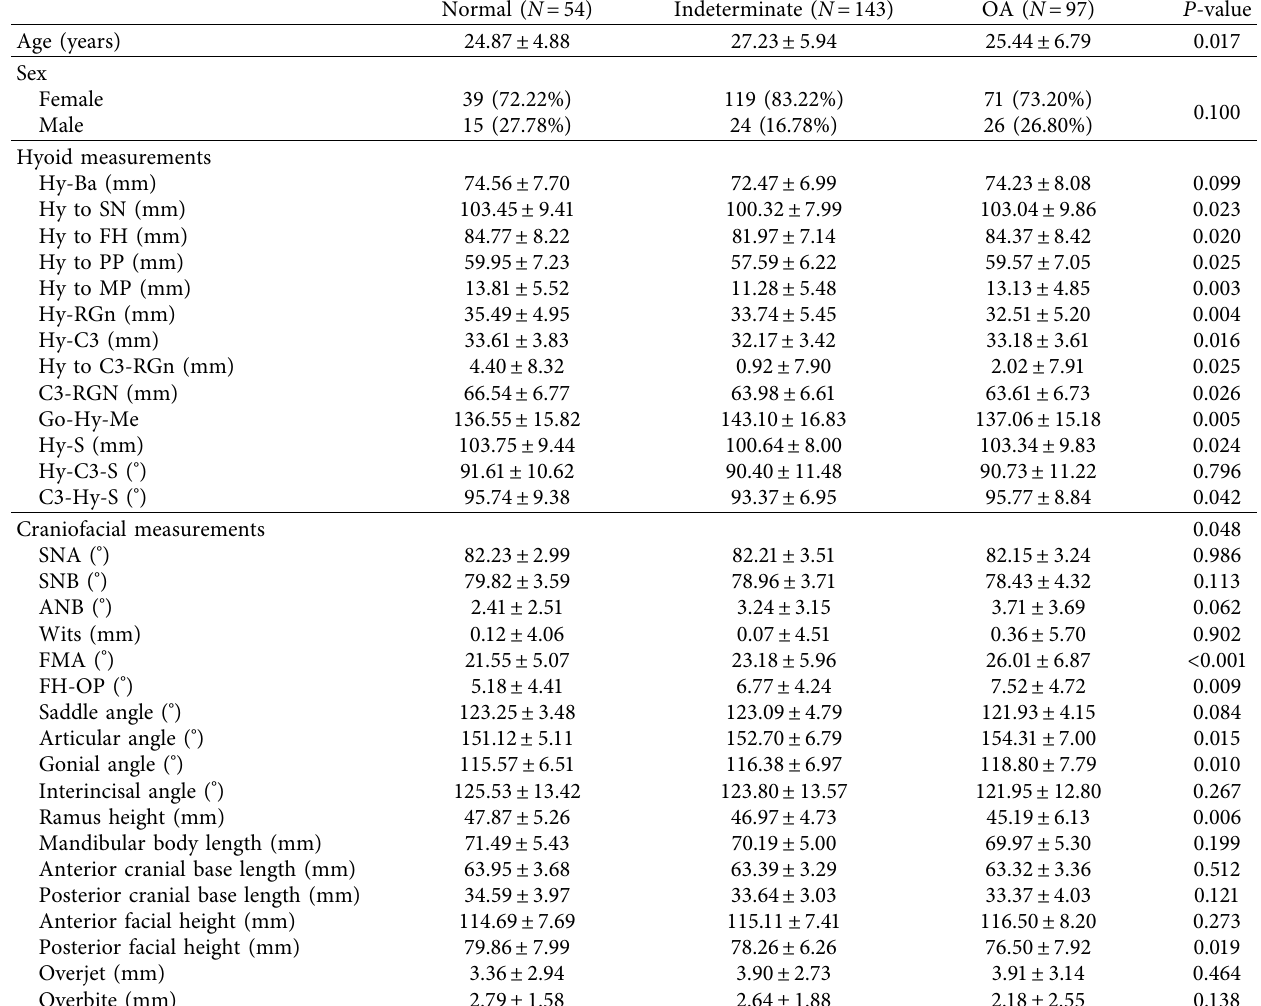
Table 8: Differences in hyoid and craniofacial measurements among the three groups in adults. Normal ( N �